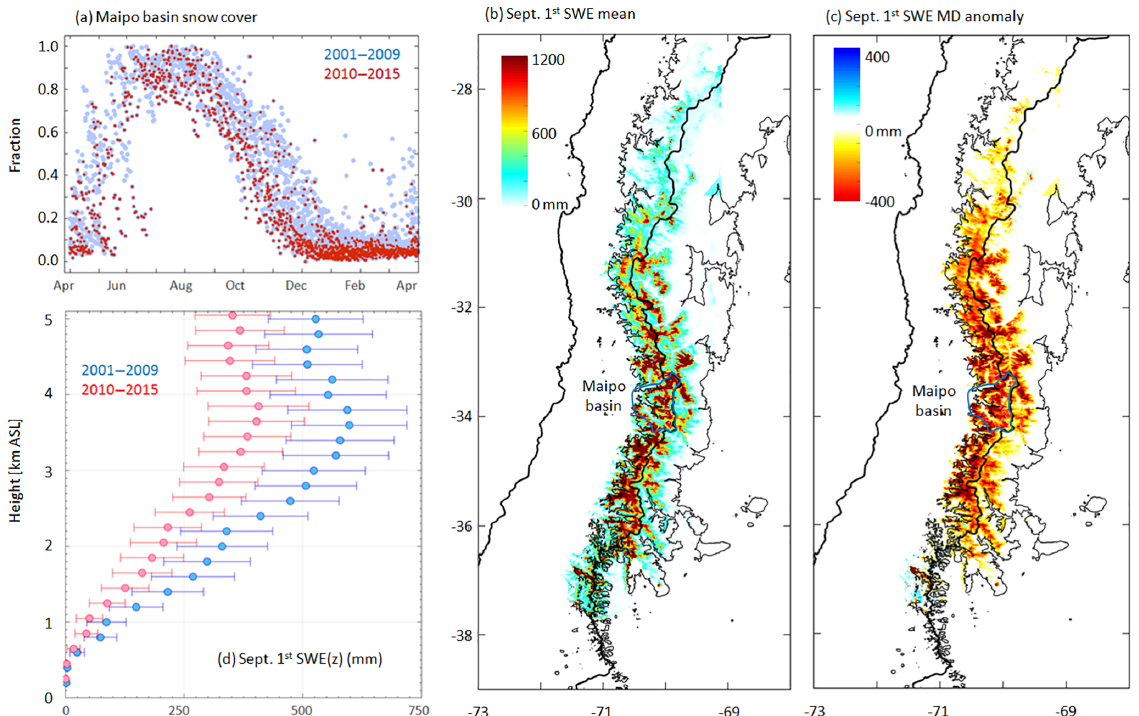
Figure 2. (a) Daily fraction of snow cover throughout the hydrological year in the upper Maipo River basin (33–34 ◦ S; outlet at 900ma.s.l.; drainage area 5400km 2 ) during 2001–2009 (blue circles) and the MD (2010–2015, red circles). Data from the MODIS MOD10A1 prod- uct. (b) Late winter (1 September) mean snow water equivalent (SWE) over the subtropical Andes. (c) 1 September MD-average SWE (2010–2015) minus the last decade mean (2001–2009). (d) 1 September mean SWE in the region 32–35 ◦ S as a function of the elevation during the MD period and the previous